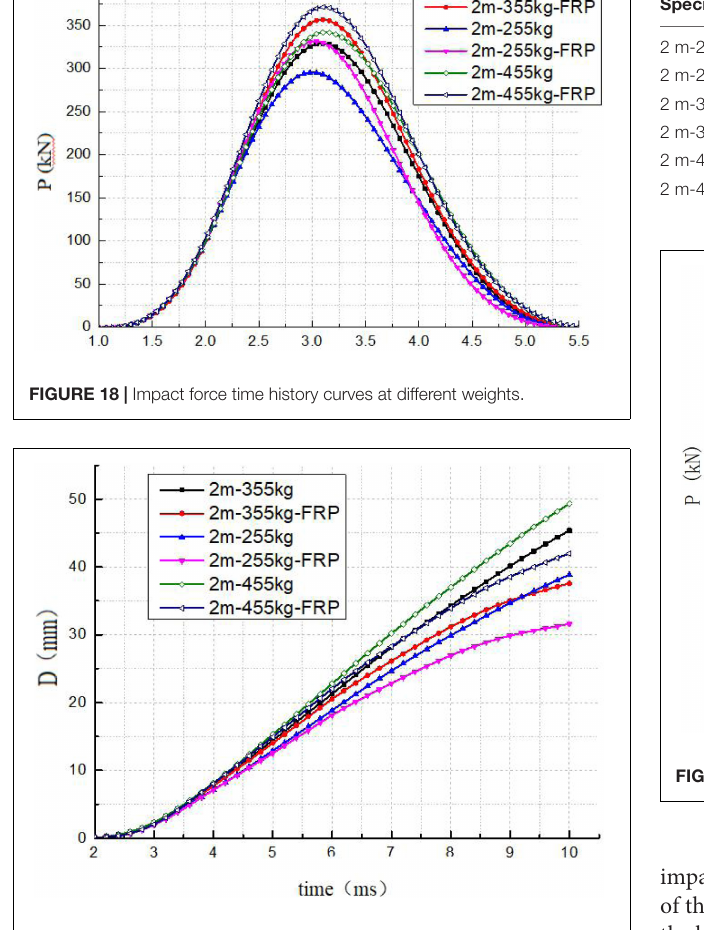
FIGURE 19 | Displacement time history curves at different weights.